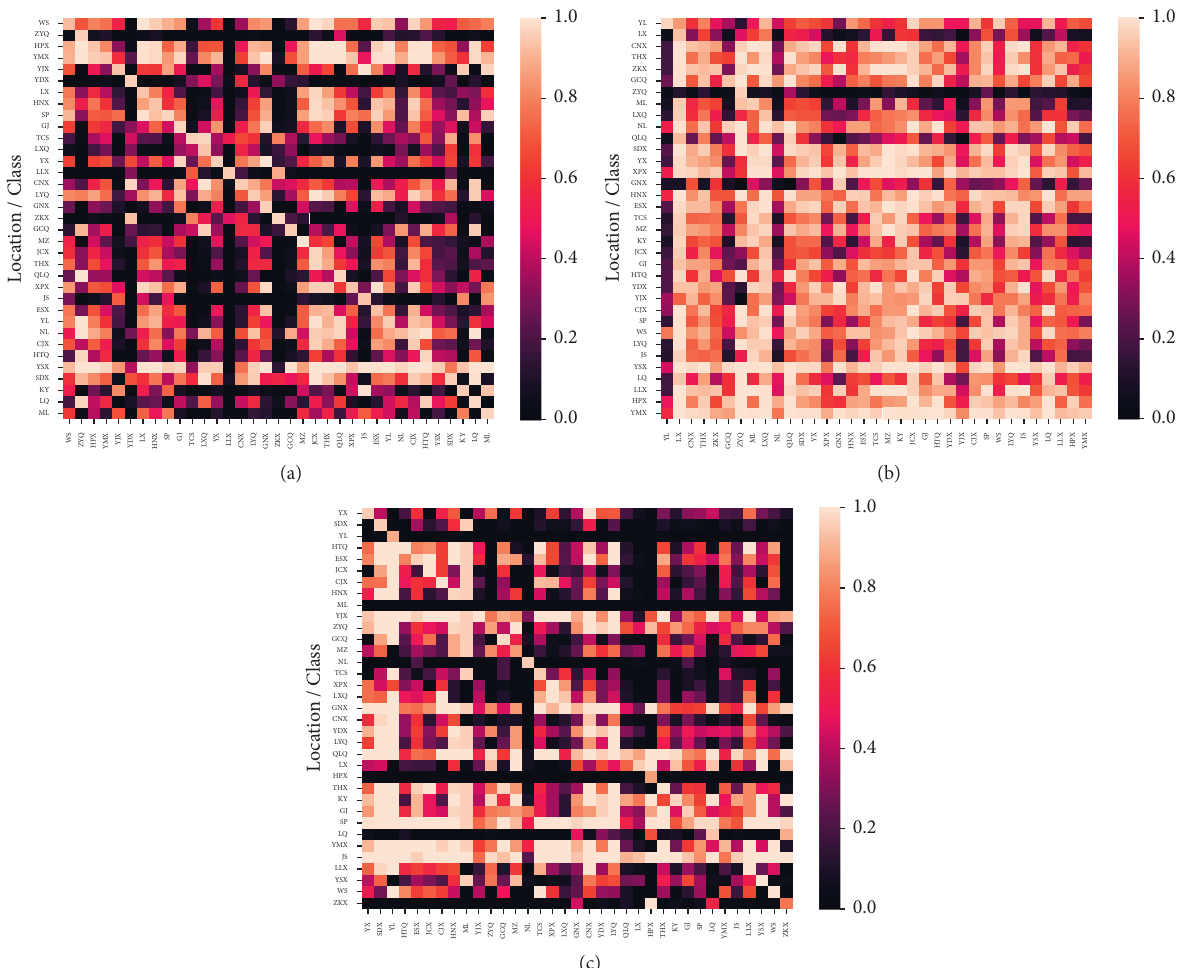
Figure 6: The correlation results of data of climate, altitude, and chemical compositions correspond to the 35 locations. (a), (b), (c) The results of climate, altitude, and chemical compositions of the 35 locations. Each grid denotes the correction results corresponding to the samples existing in the class of the i th row and j th column. The row and column can be obtained from the corresponding geographic